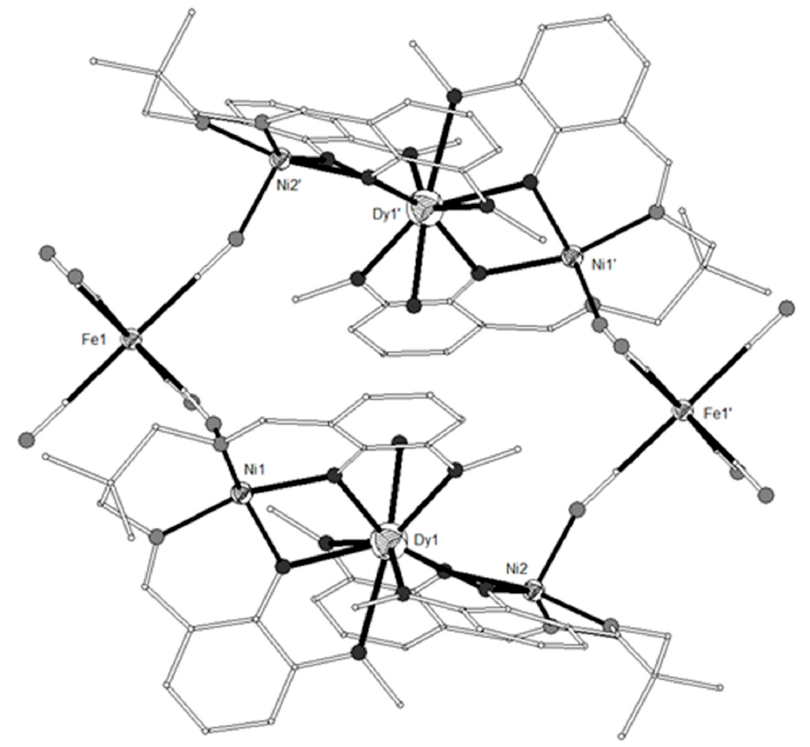
Figure 18. The molecular structure of complex [{Ni(L 19 ) 2 } 2 Dy(H 2 O)Fe(CN) 6 ] 2 ( 148 ). Primed atoms are generated by symmetry (‘) 2 − x , 1 − y , 1 − z . Color code: Dy large octant, Ni and Fe small octant, N light grey, O dark grey, C open small [54].